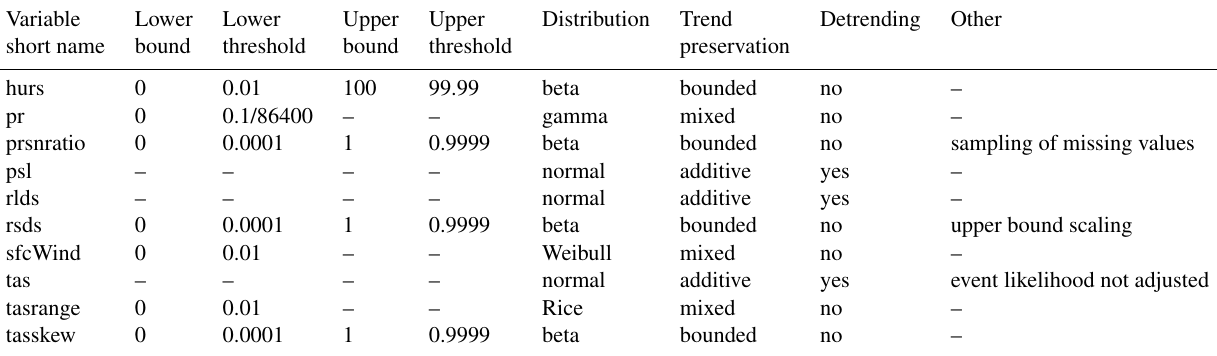
Table 2. Specification of the ISIMIP3 bias adjustment method for all climate variables considered in this study. Where a lower (upper) bound is specified, no values smaller (greater) than this bound will occur in the bias-adjusted data. For every lower (upper) bound, a lower (upper) threshold is defined, which is only slightly greater (smaller) than the bound. The lower (upper) threshold is used to adjust the relative frequency of values smaller (greater) than the threshold. Note that the units of prsnratio = prsn / pr, tasrange = tasmax − tasmin, and tasskew = ( tas − tasmin )/ tasrange are 1, kelvin, and 1, respectively. For units of the other climate variables, see Table 1. The lower threshold of pr is equivalent to 0.1mmd − 1 . For a description of the different kinds of trend preservation, see Eqs. (1)–(8) and the text around them. Variable Lower Lower Upper Upper Distribution Trend Detrending